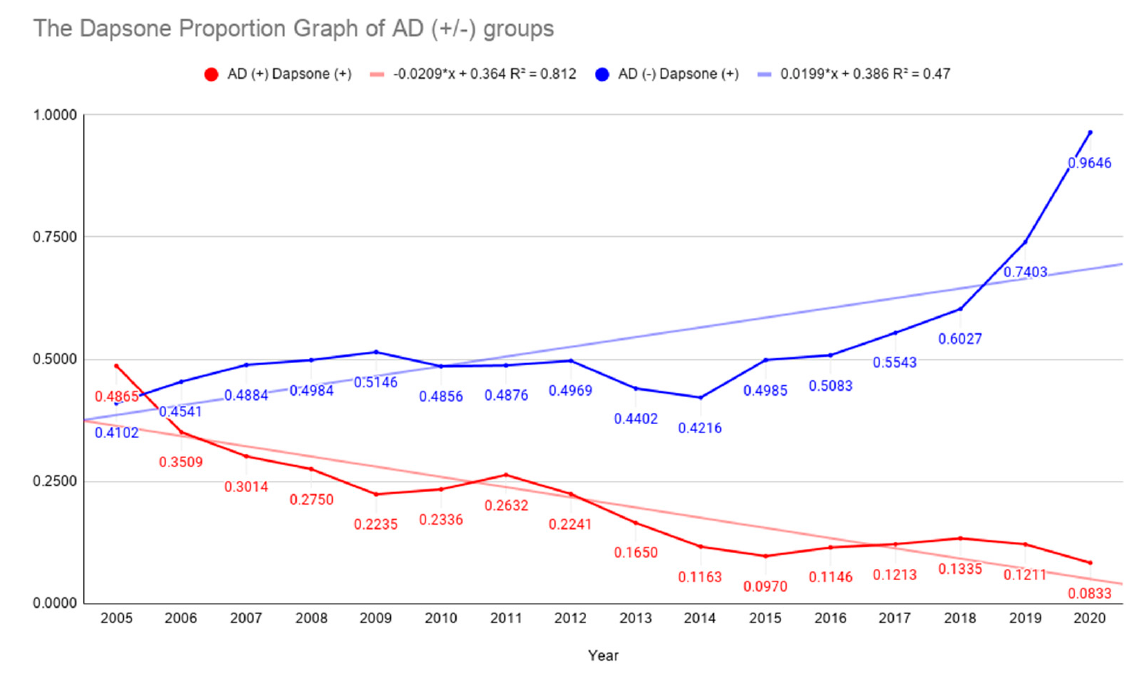
Figure 3. Dapsone proportion graph with(out) Alzheimer’s disease groups. This study was conducted from 2005 to 2020 based on the medical records of the Sorokdo National Hospital that was established in May 1916 to treat leprosy [9]. However, the patient research in the report was initiated by Sister Marianne Stoeger and Sister Margaritha Pissarek, who moved to Sorok Island in February 1962 and October 1967, respectively. They left Sorok Island on 21 November 2005, returning to their homelands. The leprosy patients here have taken dapsone all their lives. The AD prevalence rate was very low in the leprosy patient group who took dapsone regularly.